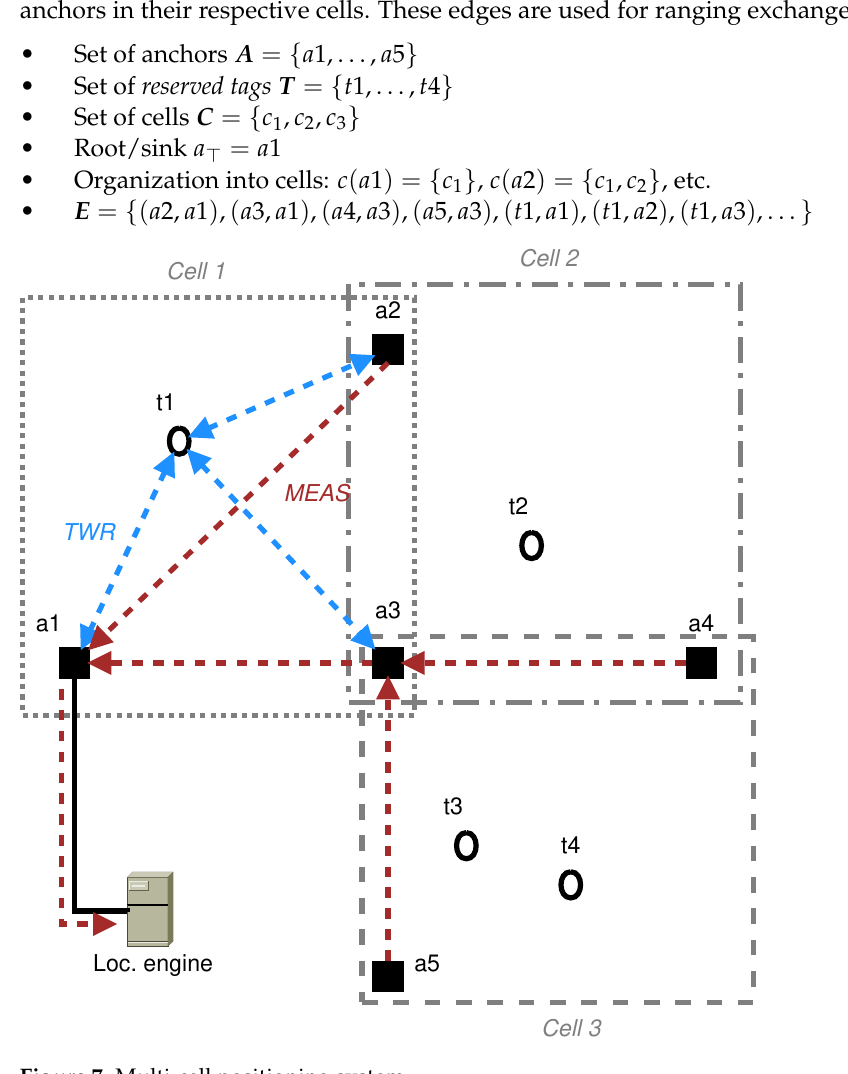
Figure 7. Multi-cell positioning system.